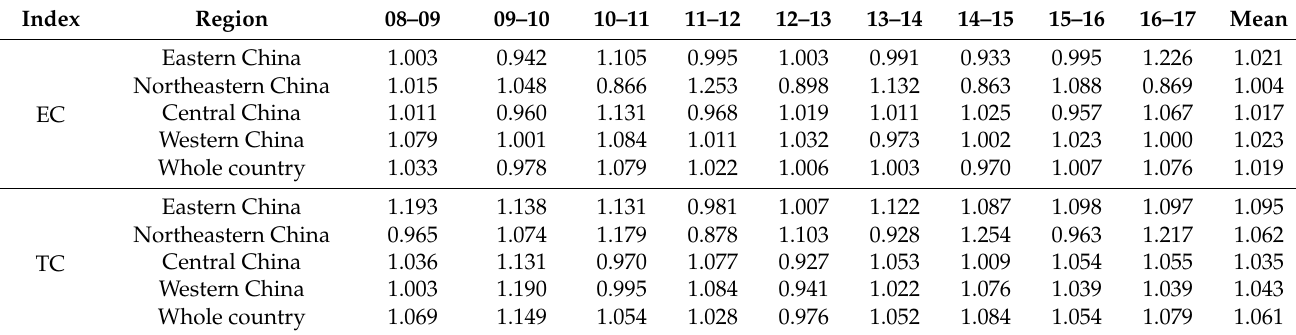
Table 6. Decomposition results of the average GML index by year for the four